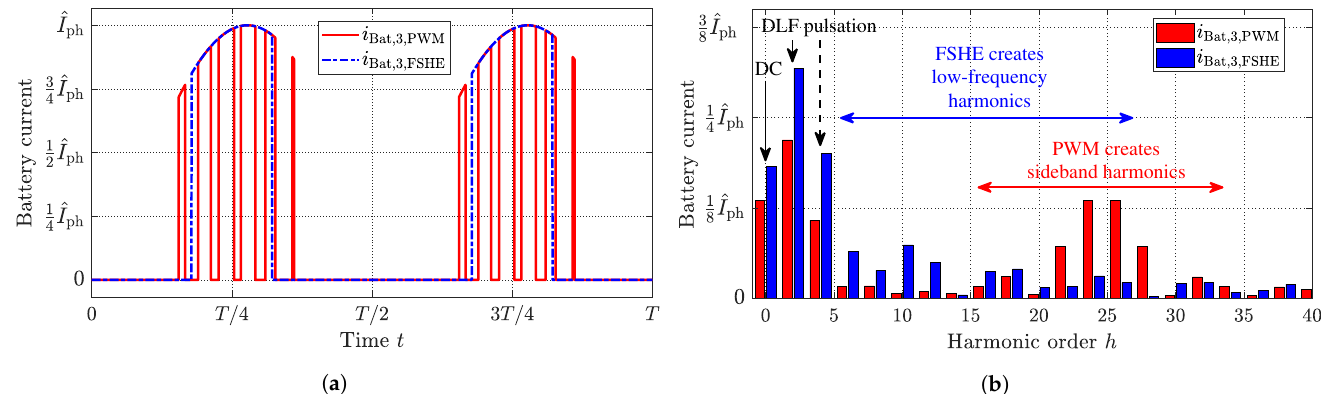
Figure 7. ( a ) Drained battery currents when using multilevel PWM and FSHE according to Figures 4 and 5; ( b ) Correspond- ing harmonic